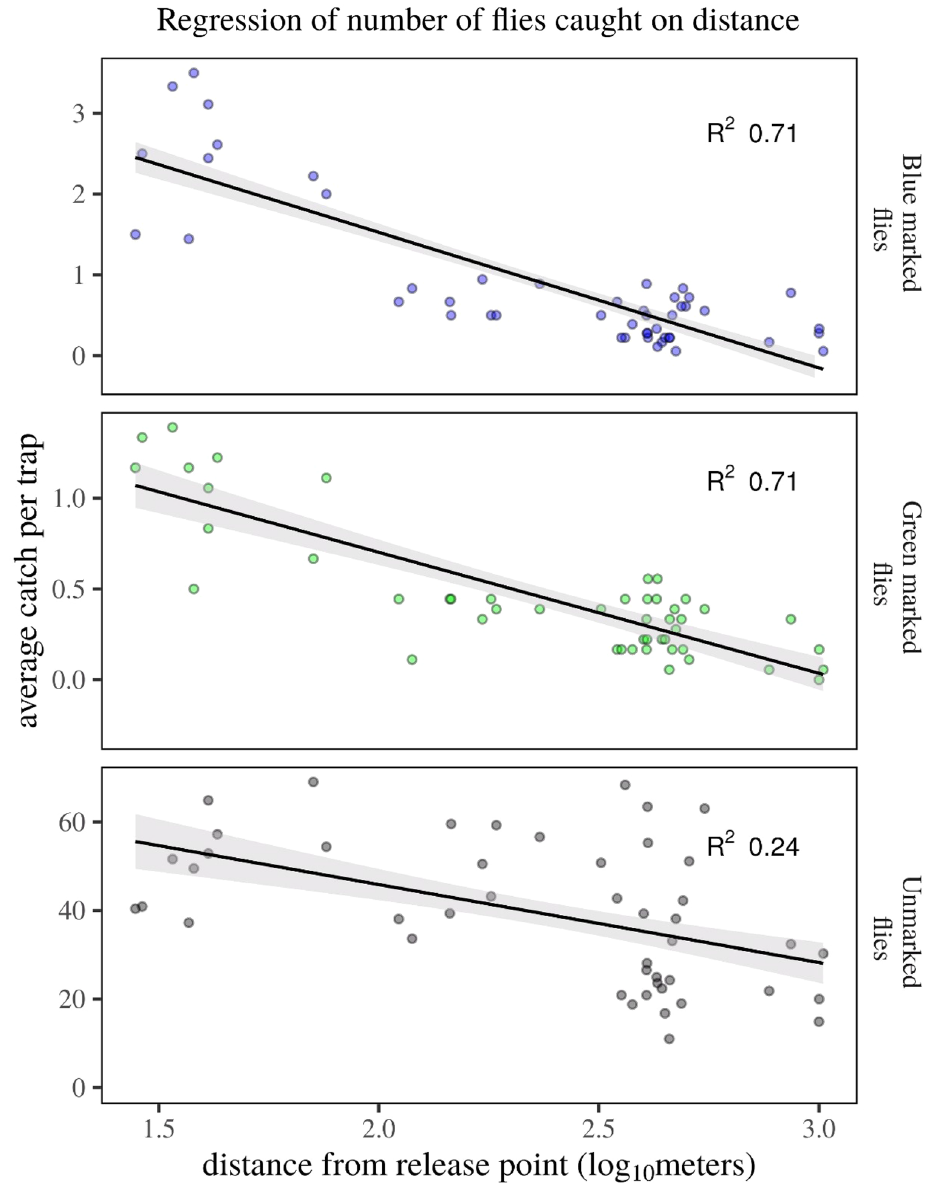
Figure 4. Regression of the number of recaptured B. dorsalis males on distance from the release point. . The number of recaptured flies declined with distance from release point (r 2 = 0.71, F(1,46) = 112.7, p < 0.001), both when trapping started immediately after release (blue-marked flies) and when release preceded recapture by 3 days (green-marked flies). As a control, capture of unmarked flies over distance showed a weak correlation (r 2 = 0.24, F (1,44) = 13.69, p <